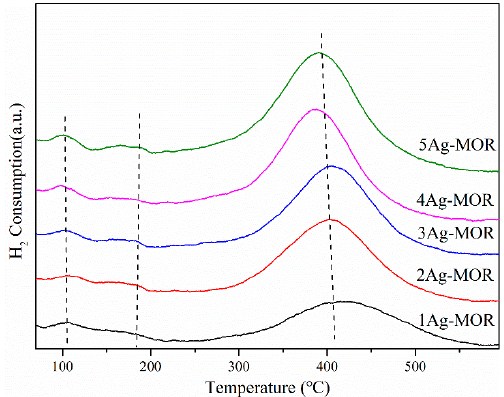
Figure 6. H 2 ‐ TPR profiles of the